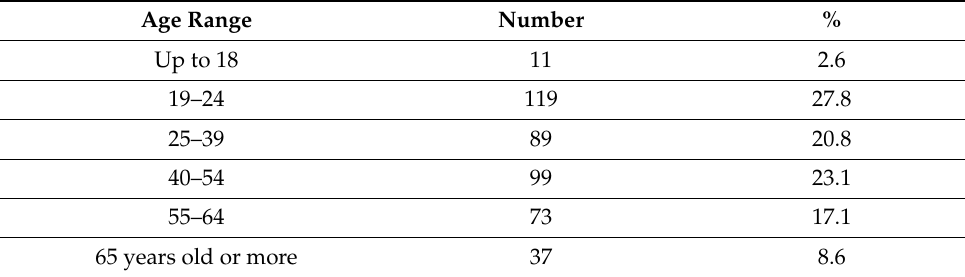
Table 1. Age distribution of the respondents.